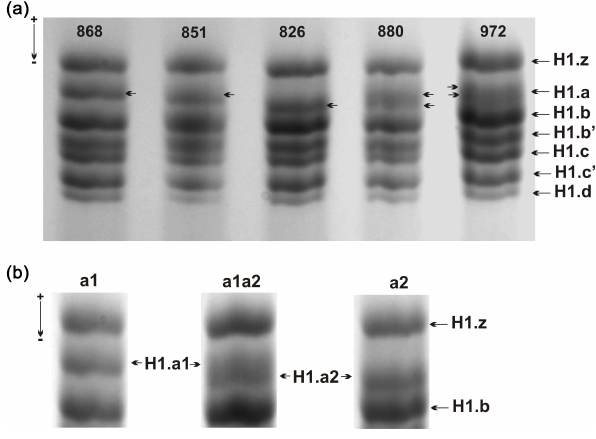
Figure 1. In (a) , a fragment of AU-PAGE gel with resolved H1 hi- stones belonging to different quail individuals marked by the num- bers. In contrast to the histone H1 subtypes H1.z, H1.b, H1.b (cid:48) , H1.c, H1.c (cid:48) and H1.d possessing invariable electrophoretic mobility, the altered electrophoretic migration of subtype H1.a is depicted by the arrows located close to the respective protein band. In (b) , the his- tone H1.a phenotypes a1, a2 and a1a2 formed by the isoforms H1.a1 and H1.a2 differ in the in-gel location with respect to adjacent sub- type H1.z and H1.b occupying the same in-gel